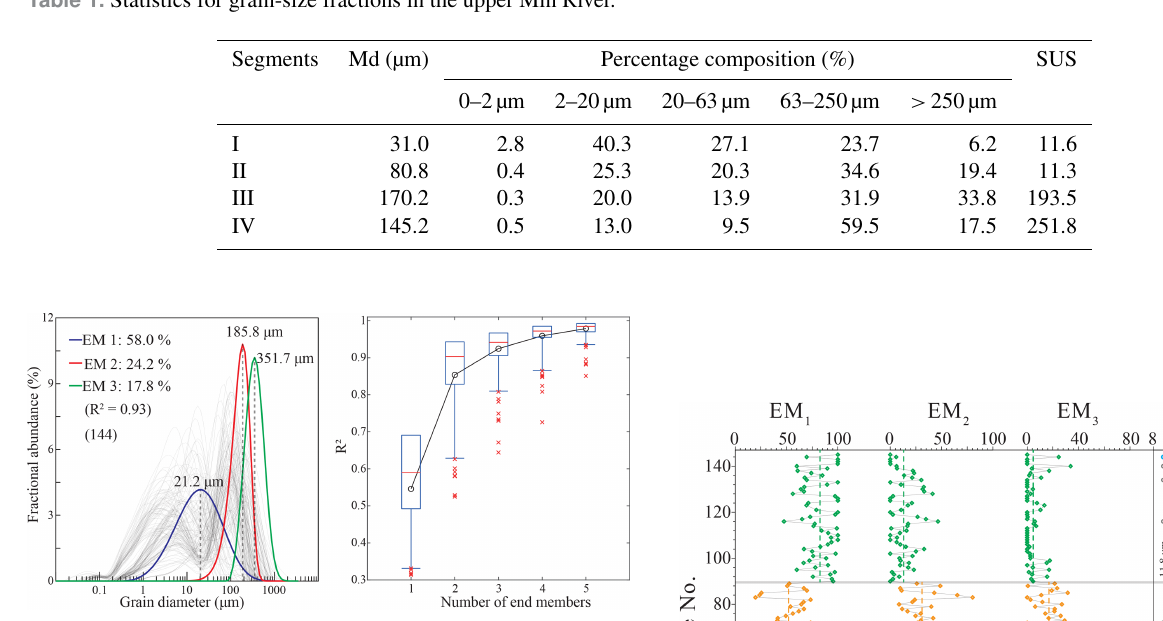
Figure 4. End-member analysis model of fluvial sediments from the upper Min River.